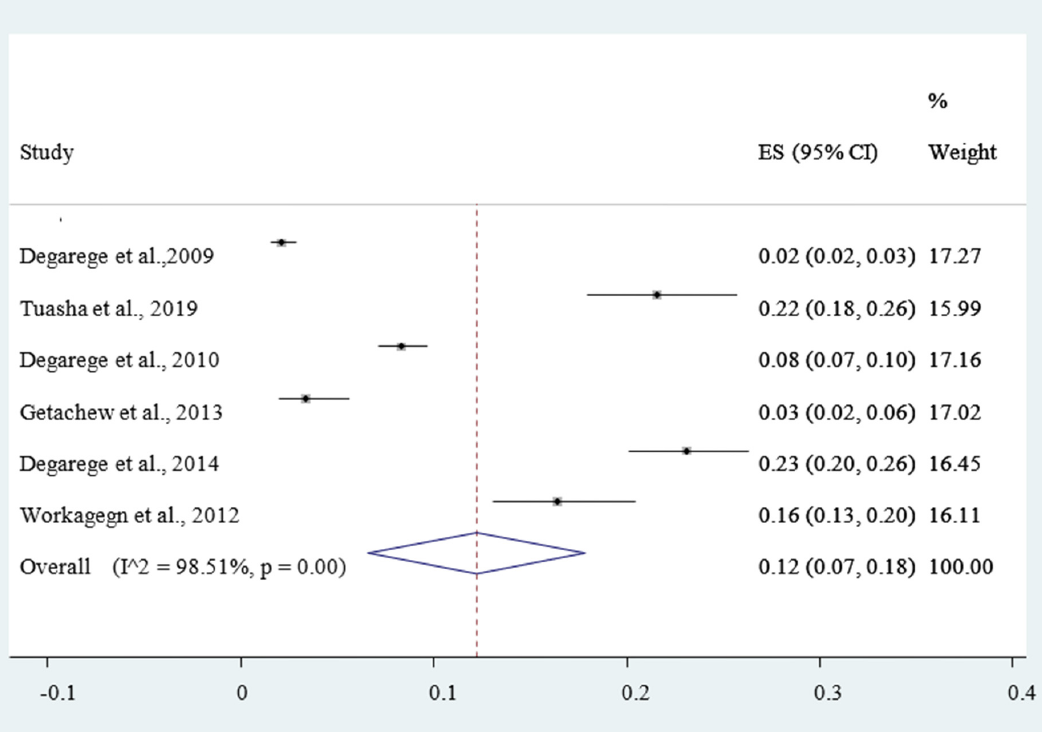
Figure 8. Forest plot of 7 studies on magnitude of Ascaris lumbricoides infection among outpatients in Ethiopia, 2020.